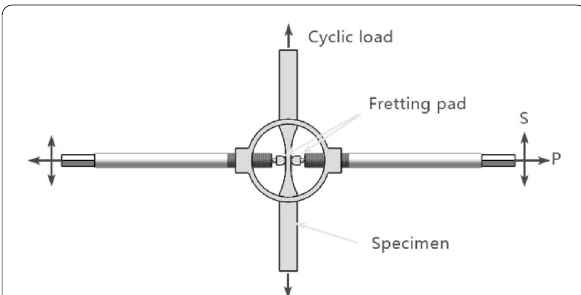
Figure 11 Schematic of fretting wear